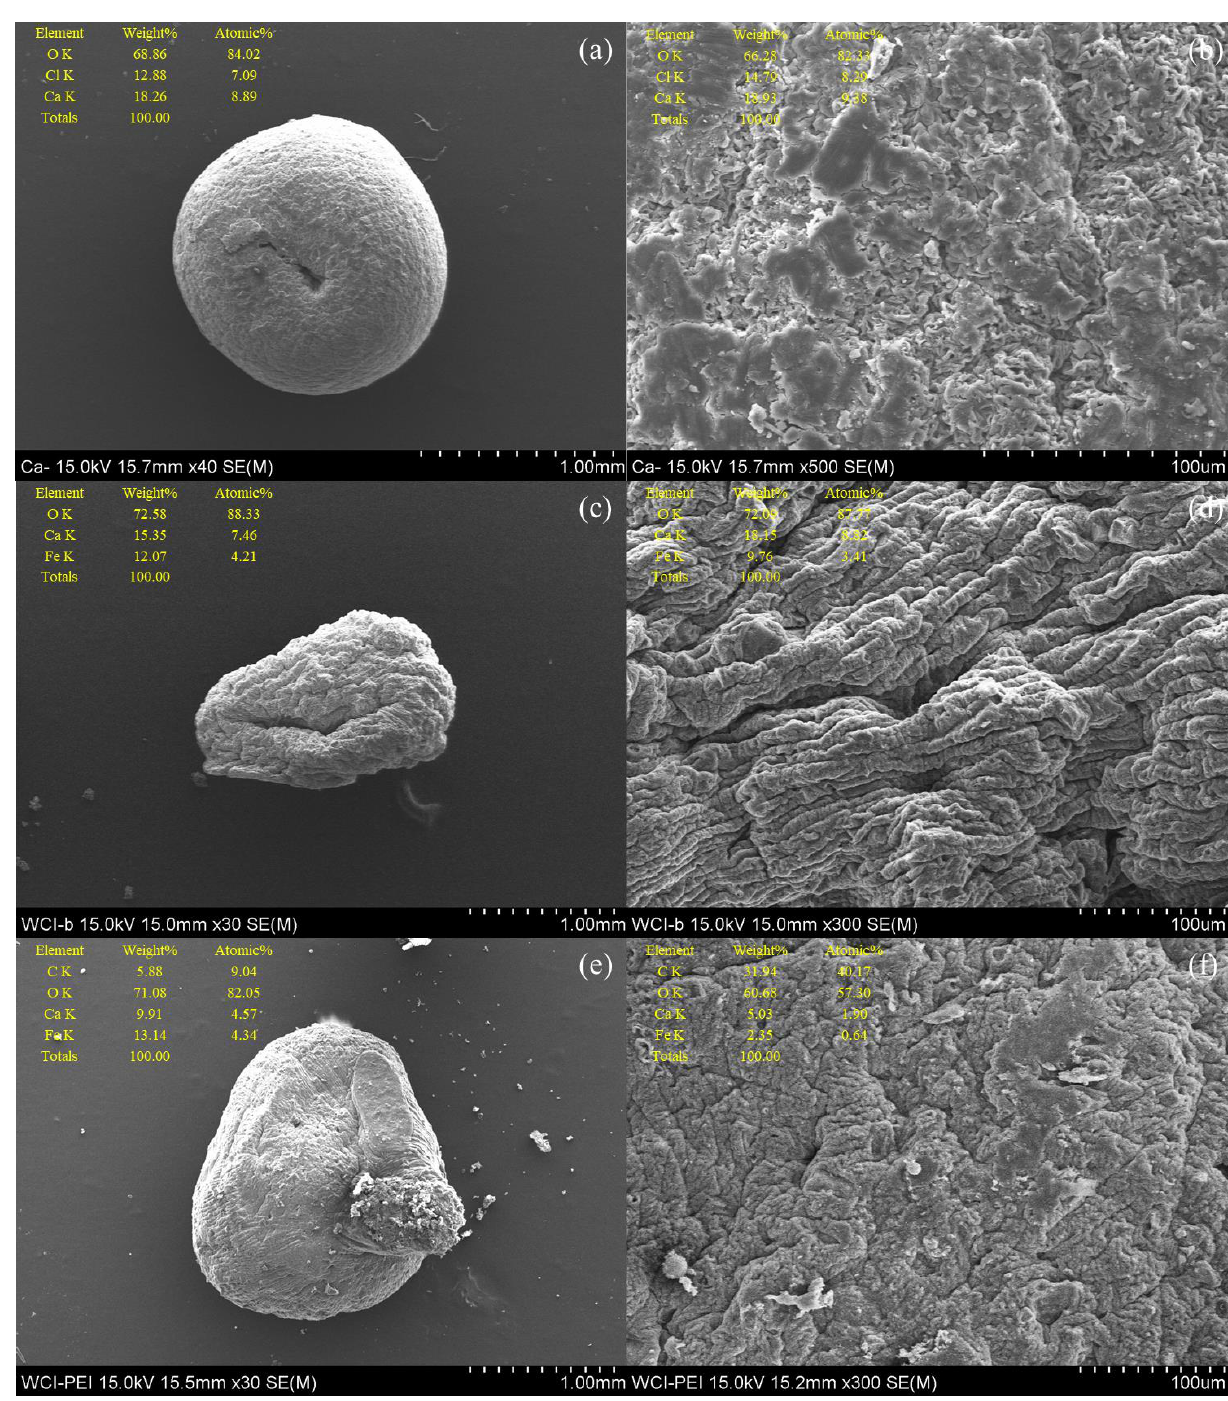
Figure 6. SEM images and EDS analysis of element content of ( a , b ) Ca-alginate bead, ( c , d ) WFD/SA bead, and ( e , f ) WFD/SA-PEI bead at two different magnifications. bead, and ( e , f ) WFD/SA-PEI bead at two different magnifications. face area and total pore volume of WFD/SA-PEI were determined to be 1.06 m 2 /g and 0.002 cm 3 /g,